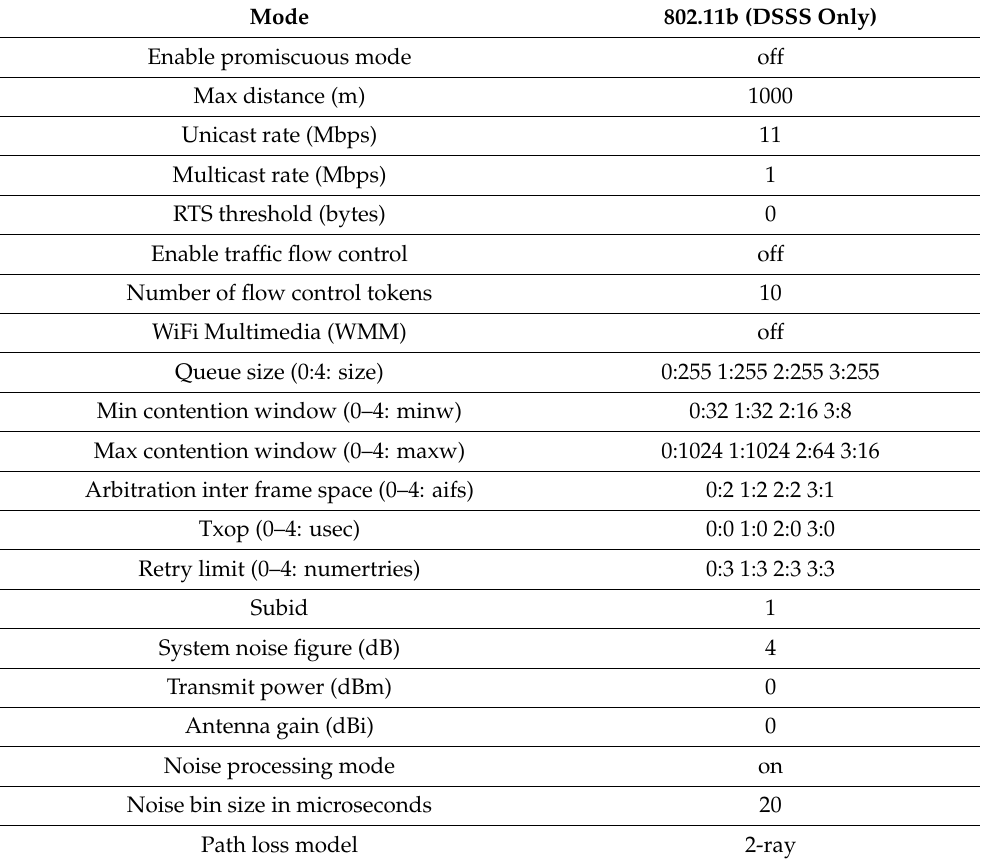
Table 1. Simulation parameters (in physical and MAC